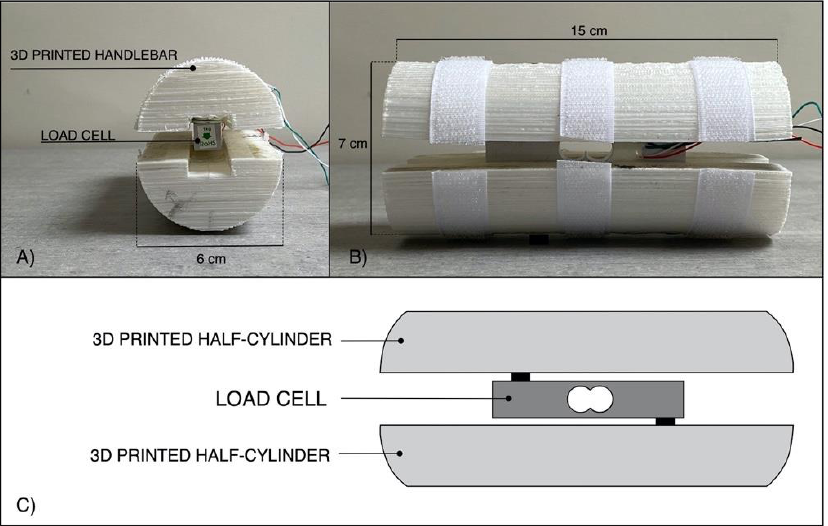
Figure 1. 3D printed handlebar for the load cell: ( A ) transversal view; ( B ) lateral view; ( C ) rendering of the exploded components in lateral view.